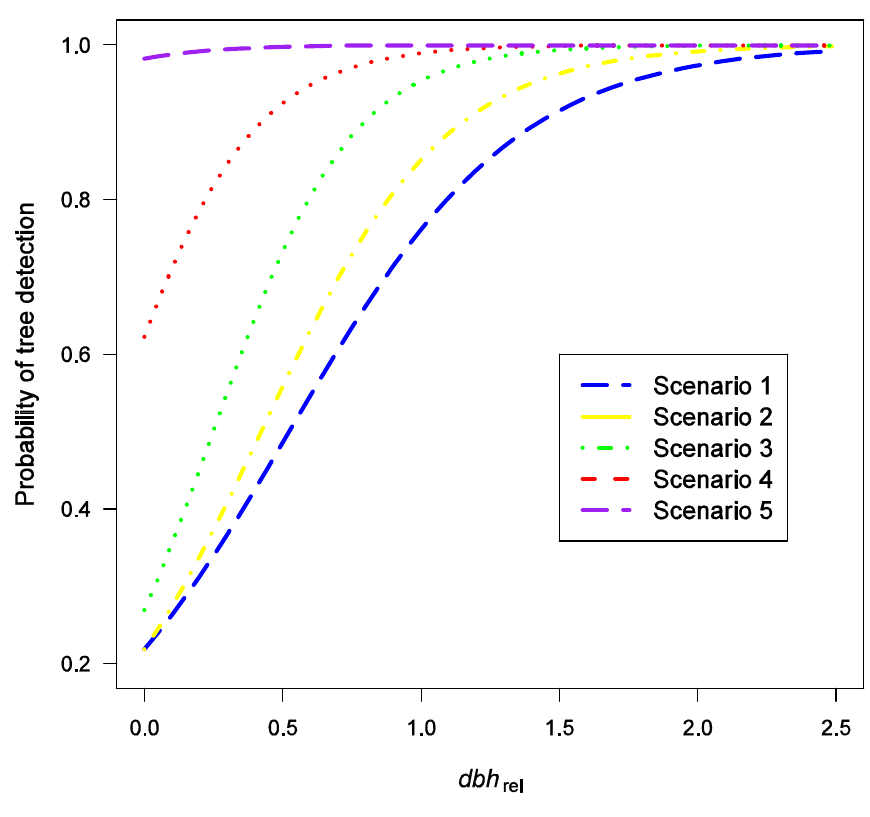
Figure 1. The probability of tree detection with five different tree detection scenarios depending on tree’s relative size ( dbh rel